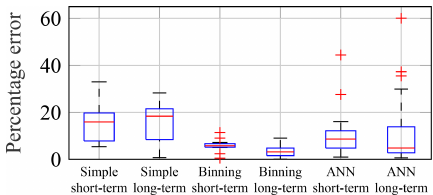
Figure 27. Percentage errors of predicted yearly damage values us- ing all extrapolation methods compared to real damage values. Data concern both short-term (13 different consecutive years) and long- term predictions (1 year extrapolated to a non-consecutive second year for 26 different